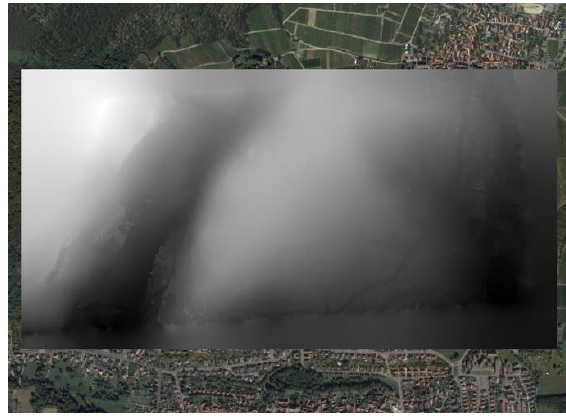
Figure 10. Processed DTM with closed gaps.